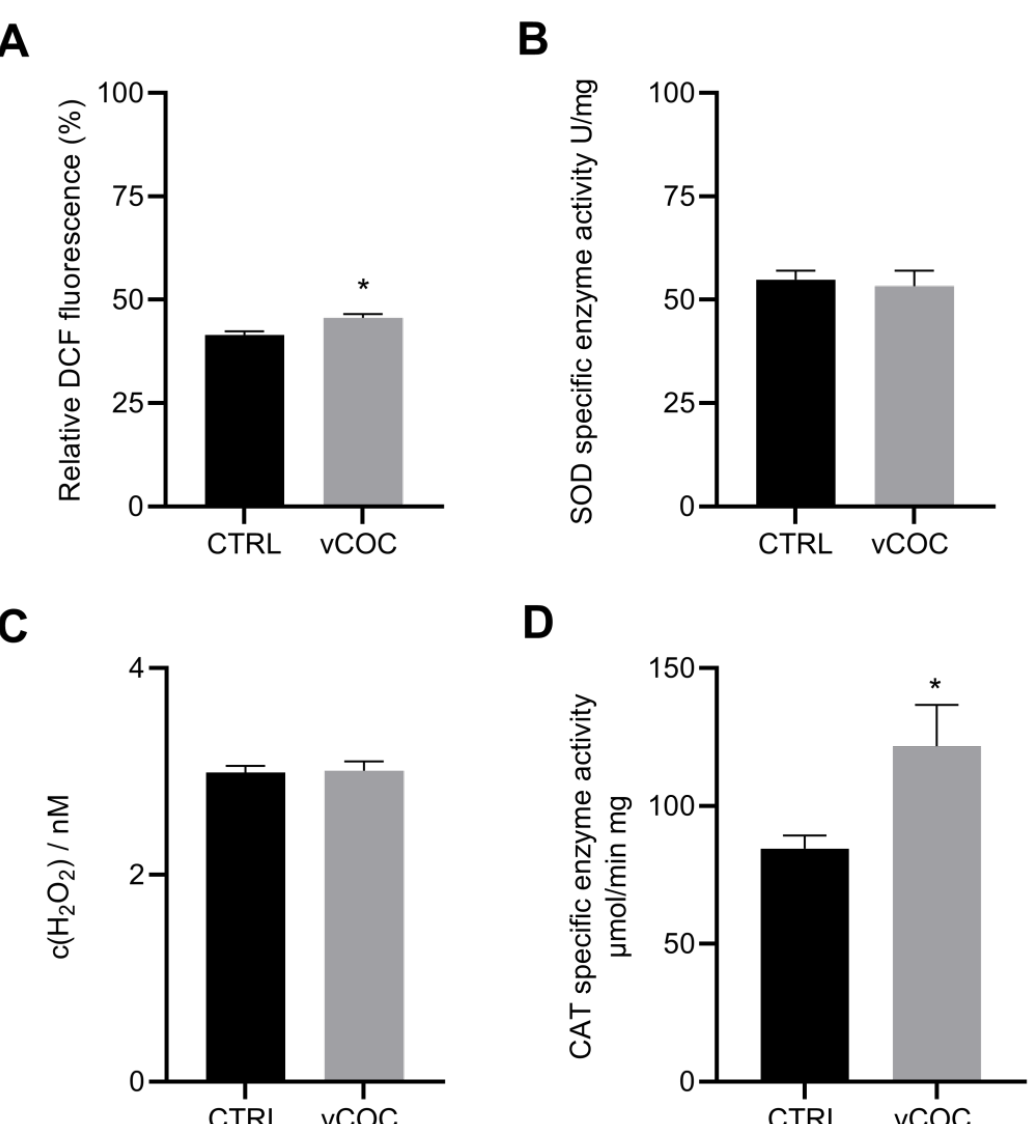
Figure 2. Single vCOC exposure increases ROS levels and CAT enzyme activity in the whole body of wt flies. Male flies were exposed to 75 µ g of volatilized cocaine (vCOC), or hot air control (CTRL) at 07:00. Six hours later we measured: ( A ) reactive oxygen species (ROS) as percent of 2 (cid:48) ,7 (cid:48) - dichlorofluorescein (DCF) relative fluorescence units (RFU), ( B ) superoxide dismutase (SOD) specific enzyme activity as % of quercetin oxidation inhibition, ( C ) hydrogen peroxide (H 2 O 2 ) concentration using calibration curve for dihydroethidium (DHE) and ( D ) catalase (CAT) specific enzyme activity as decline in H 2 O 2 concentration. All measurements were performed in triplicate ( n = 9). *: p < 0.05 using unpaired Student’s t